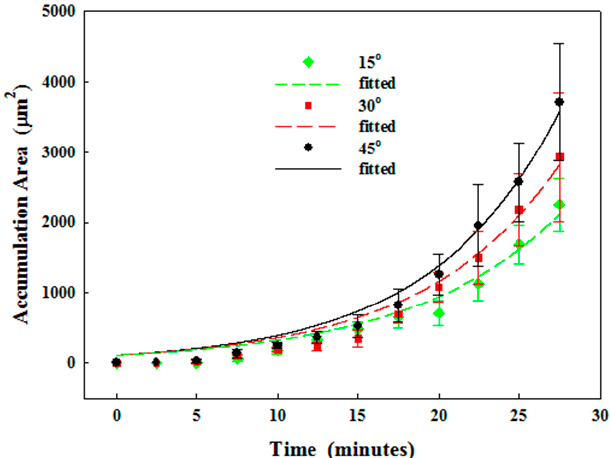
Figure 11. Progressive particle accumulation in the microchannel at the constriction angle of 15°, 30°, and 45° with 1% microparticles in water and actuation of the standing surface acoustic wave (SSAW).